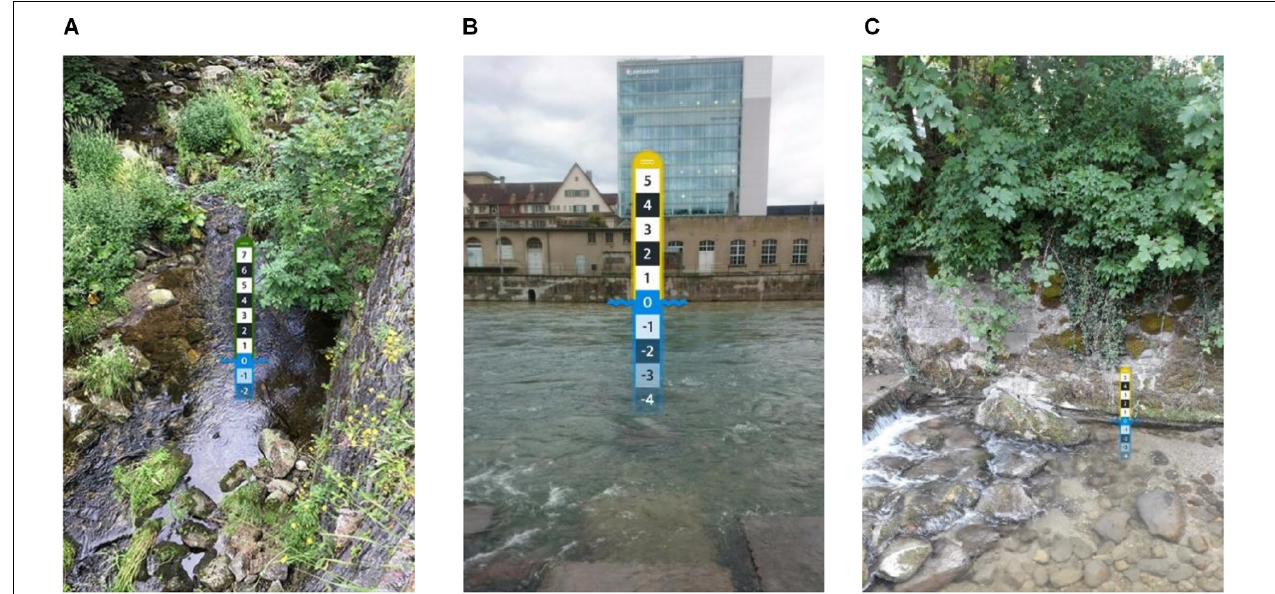
FIGURE 10 | Examples of misplaced virtual staff gauges: (A) The picture was taken in the upstream direction instead of perpendicular to the flow direction, which makes it impossible to estimate subsequent stream level changes, (B) The virtual staff gauge is so large that it is unlikely that the water level will reach different classes and is therefore improbable to obtain an approximate representation of the stream hydrograph, (C) The small virtual staff gauge can show small changes in the stream level, but cannot represent very high flows as anything above a medium flow falls into the highest